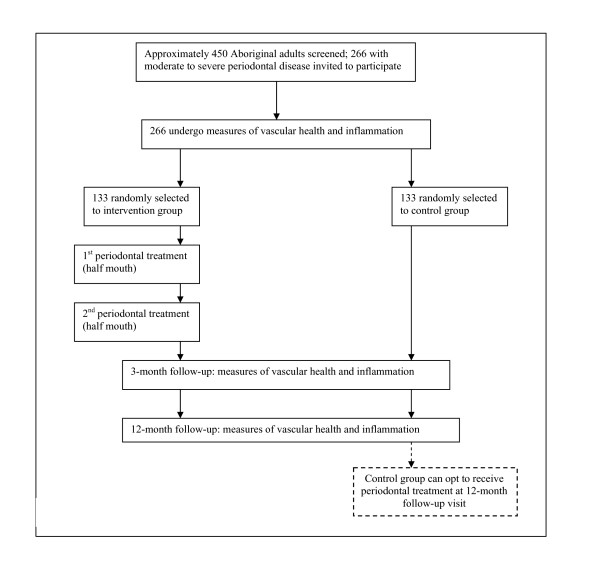
Study plan schema.